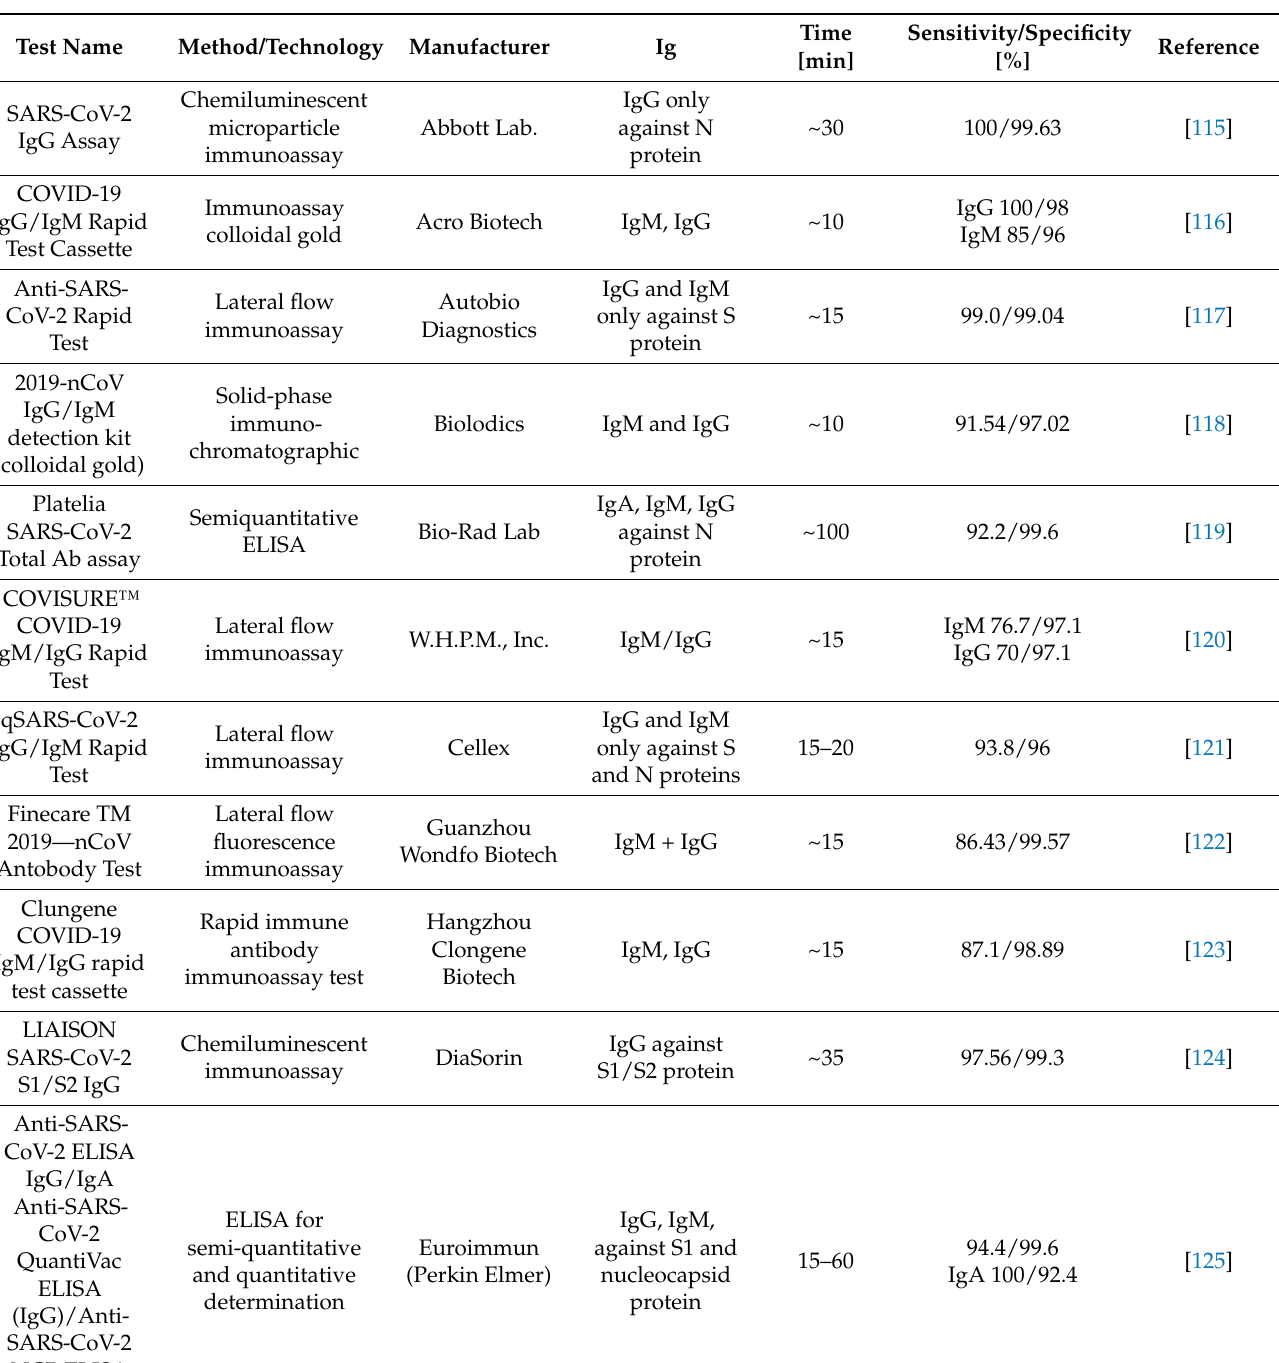
Table 2. Main commercially available serological